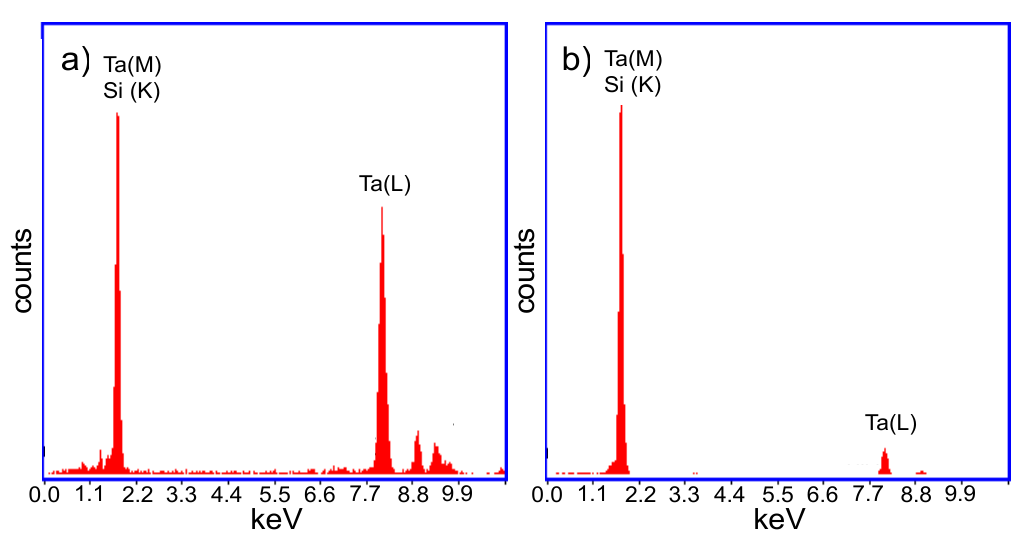
Figure 3. Energy dispersive X-ray fluorescence (EDX) spectra of ( a ) The darker (TaSi 2 ) region; and ( b ) The lighter (Si) region of the obtained TaSi 2 /Si JL nanoparticles.